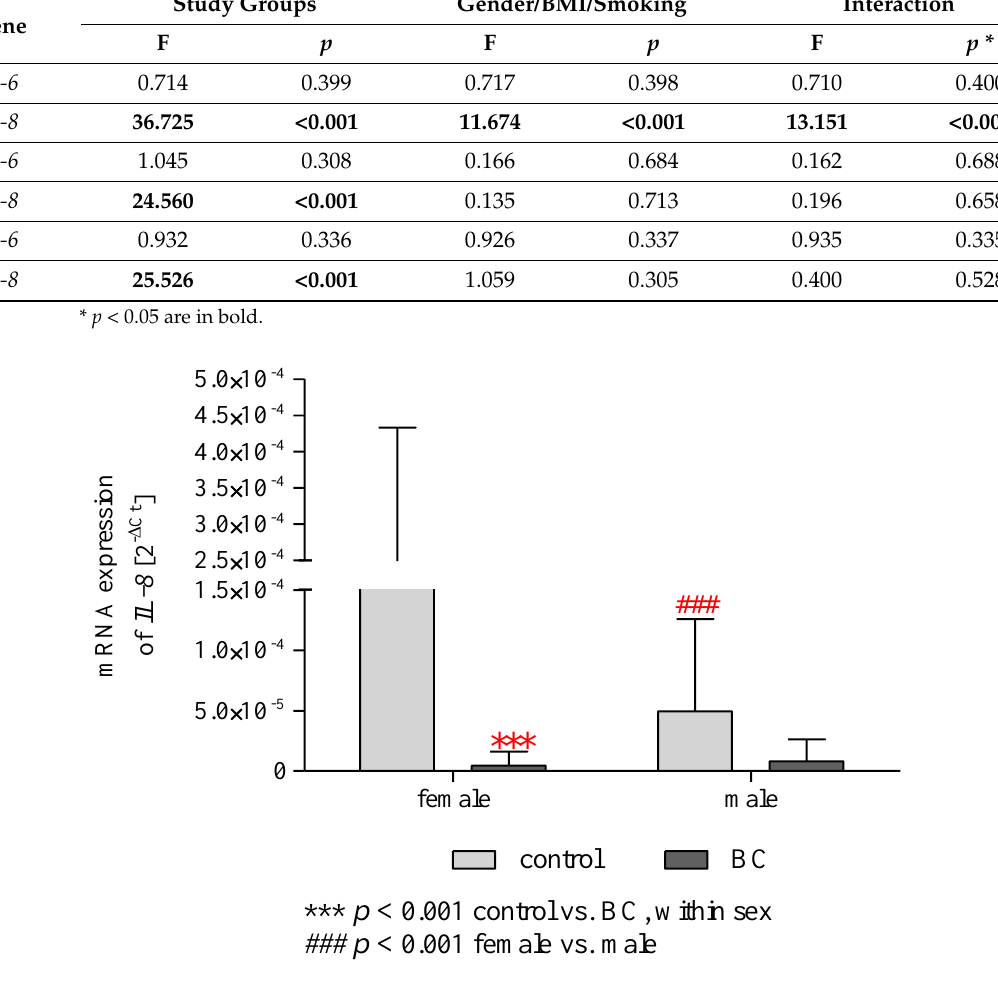
Figure 5. Two-way ANOVA with Bonferroni post hoc tests shows significant effects for gender and BC on the mRNA expression of IL-8 . Gene expression in PBMCs is expressed using the 2 − ∆ Ct (C t gene − C t 18S ) method. The data are presented as mean ± SD.